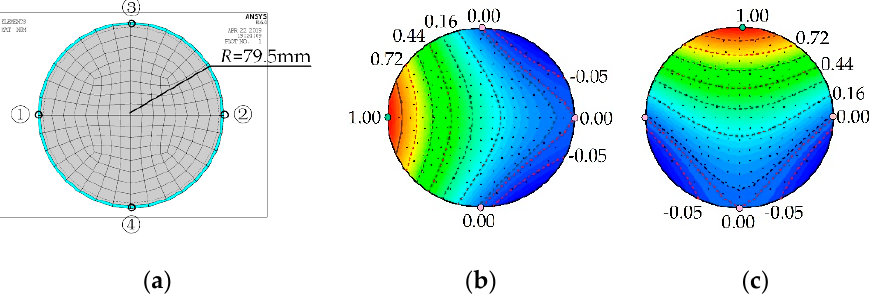
Figure 1. Finite element (FE) model and numerical shape functions: ( a ) The FE model of the cross-section; ( b ) numerical shape function N 1 ; ( c ) numerical shape function N 3 .